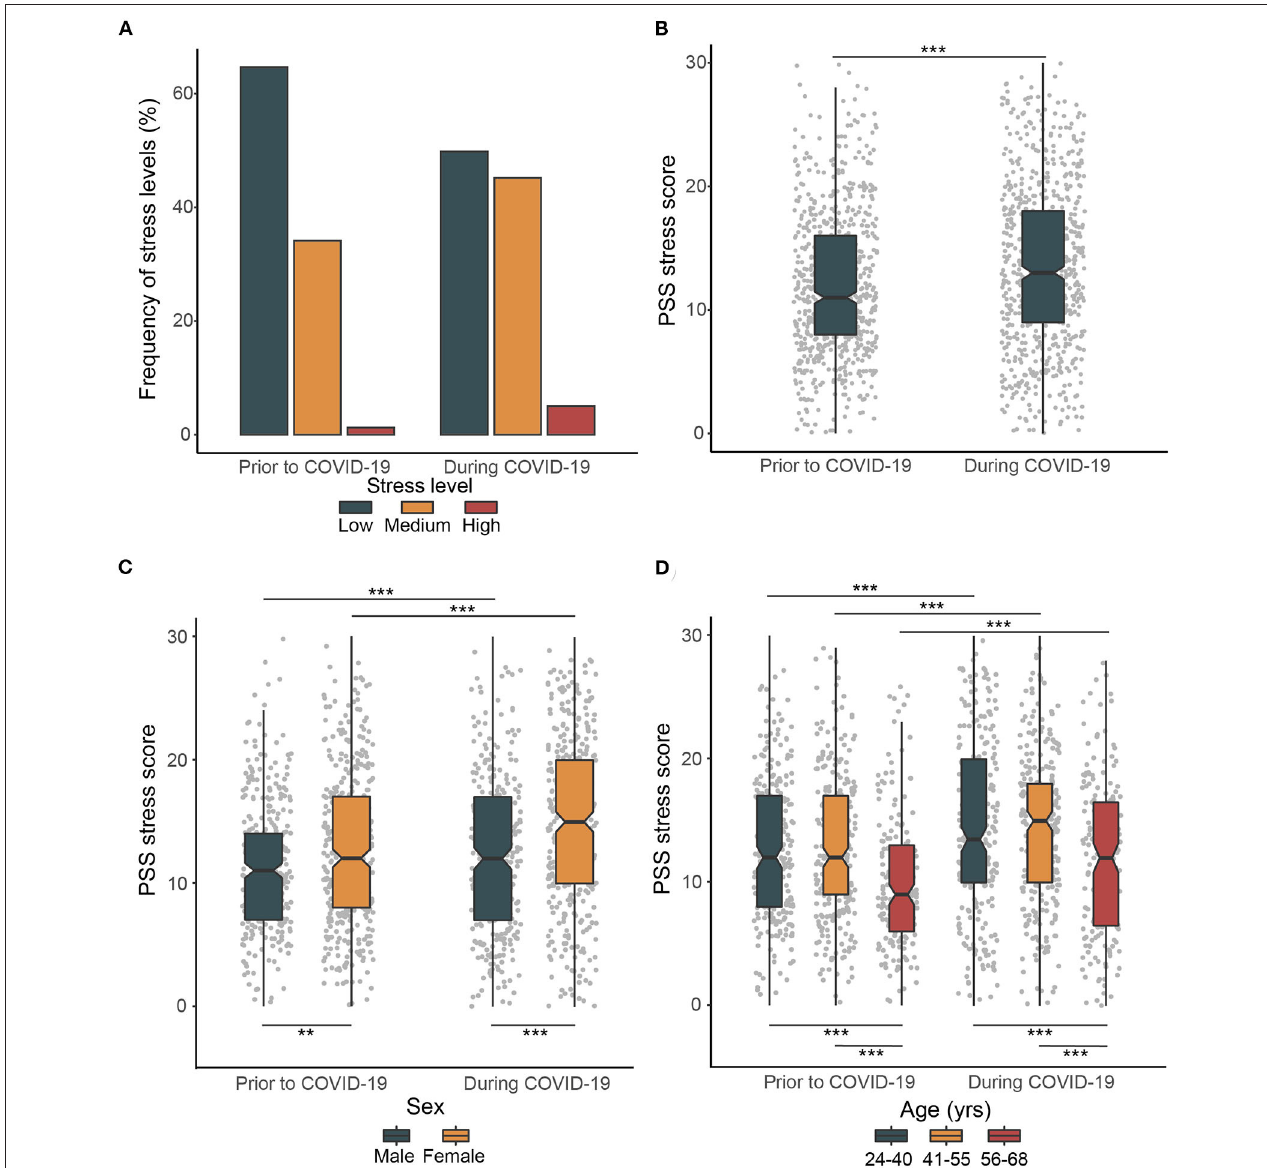
FIGURE 1 | Prevalence of stress level prior to and during COVID-19 lockdown. (A) Frequency of stress levels prior to and during COVID-19 lockdown. (B) Changes in PSS stress score prior to and during COVID-19. (C) Sex differences in changes in stress levels prior to and during COVID-19. (D) Age group differences in changes in stress levels prior to and during COVID-19. The box plots with whiskers represent the median and the first and the third quartiles are extended by 1.5 times the interquartile range. Upper horizontal bars indicate significant differences in stress levels prior to and during COVID-19, lower horizontal bars indicate significant cross-sectional differences in stress levels between individual groups (** P < 0.01, *** P <